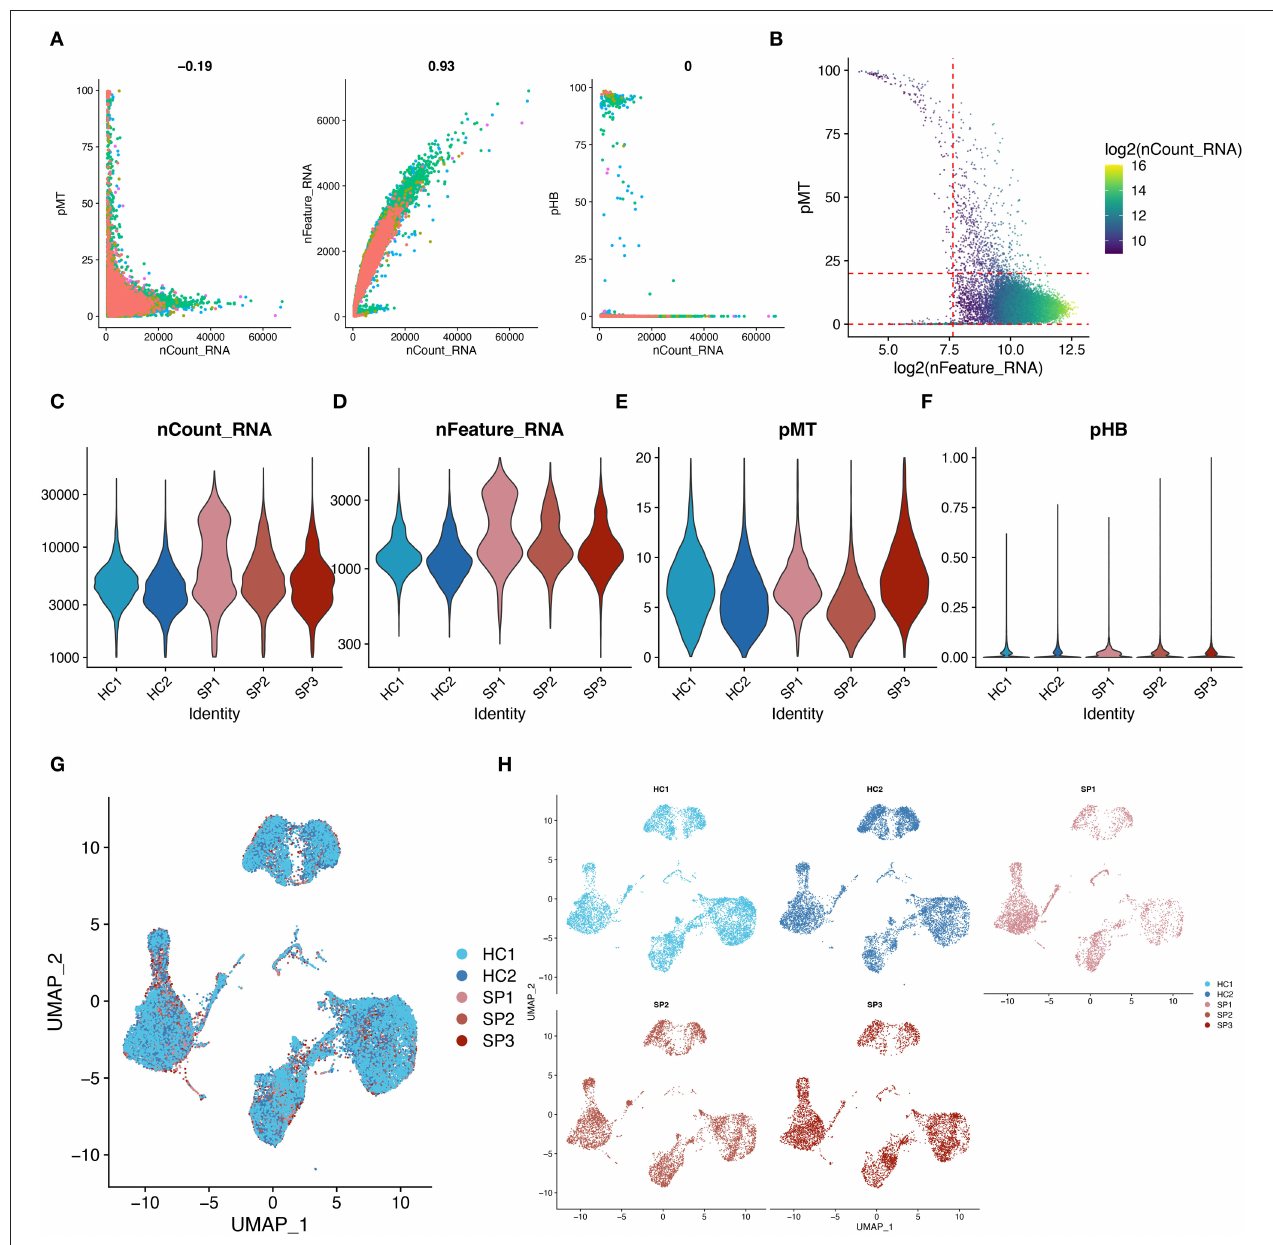
FIGURE 1 | Quality control and data integration of single-cell datasets. (A) Scatter plot showing the relationship between cell characteristics in the single-cell data before data filtering. (B) Scatter plot showing the relationship between cell characteristics, mitochondrial proportions (pMT), and RNA counts. The red line represents the threshold used in performing cell mass filtering. (C–F) Violin plots showing the distribution of cellular features in each sample after data filtering. (G,H) UMAP showing the overlaps and distribution of single-cell data after integration. These plots show the removal of batch